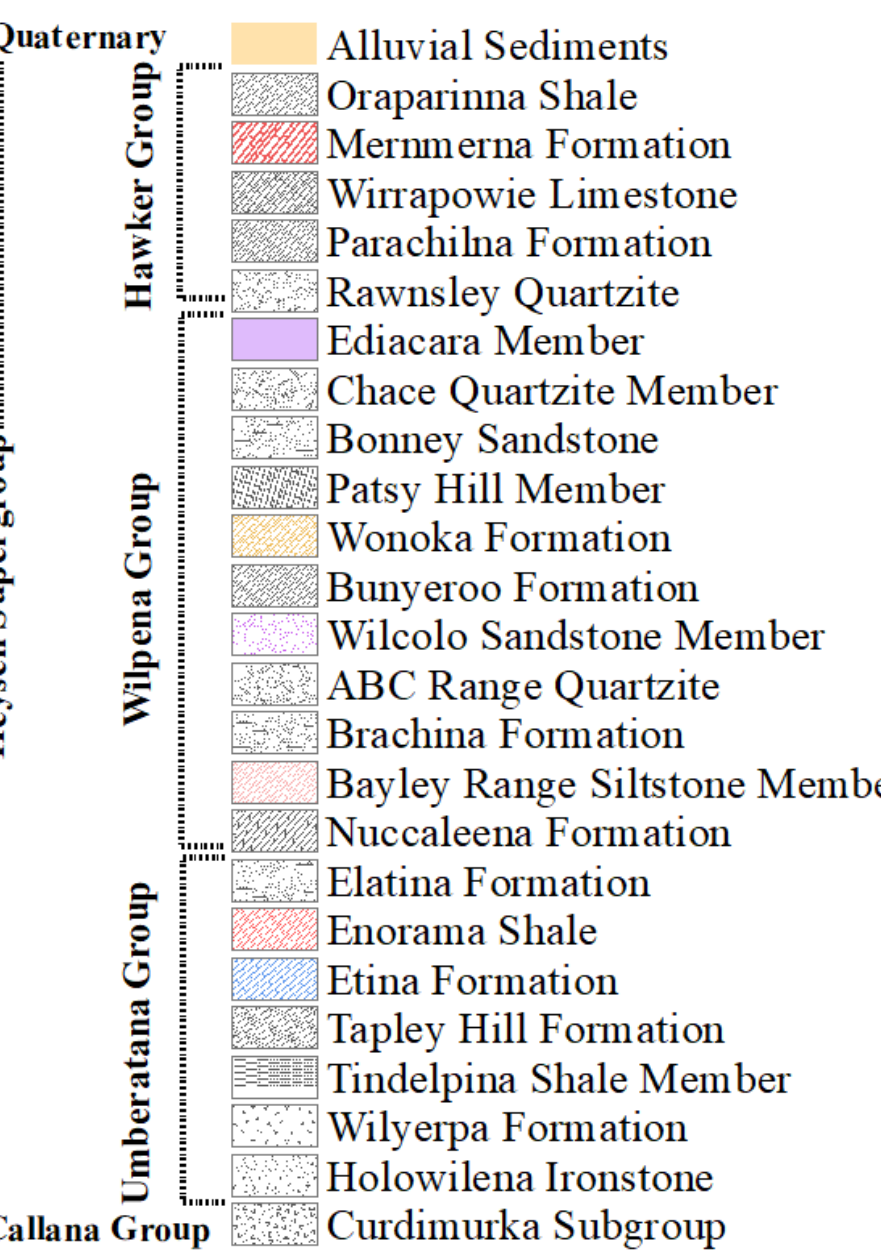
Figure 3. Stratigraphic units in the study area [31–33] .